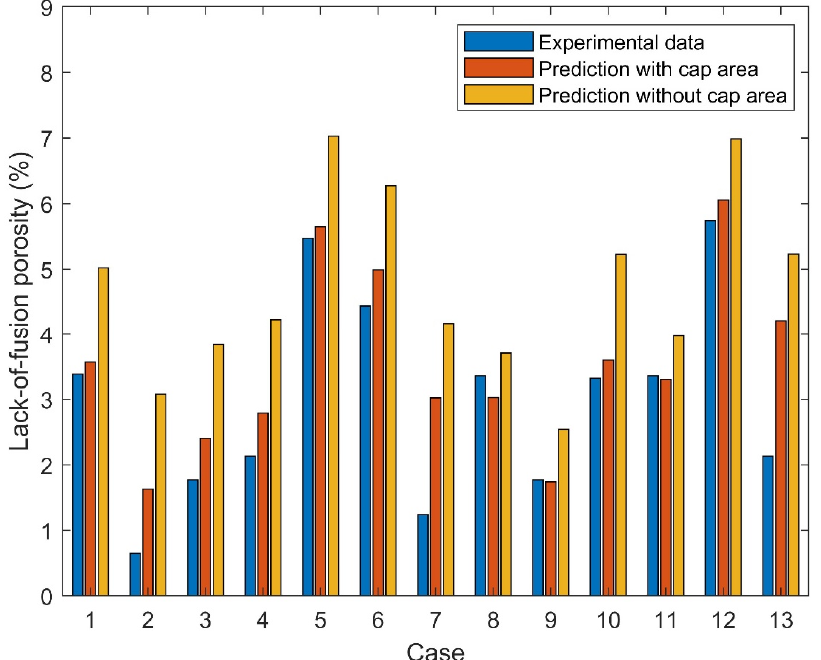
Figure 8. Comparison among predictions considering cap area with experimental data and predic- tions without cap